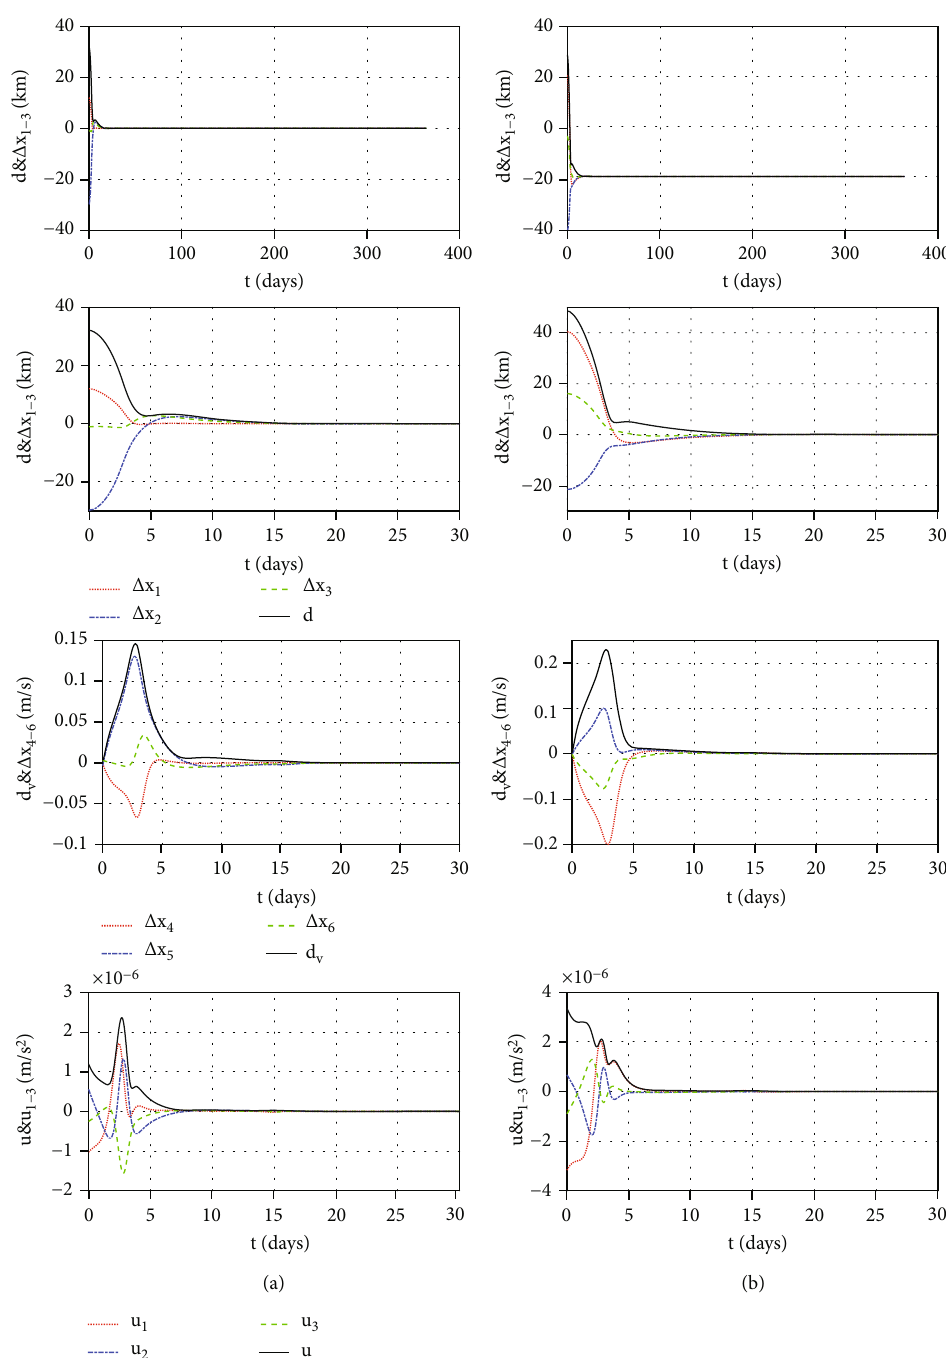
Figure 5: The position deviations, velocity deviations, control inputs, and the zoomed fi gures when the LQR (a) and OSMC controllers (b) are applied to the halo (3)